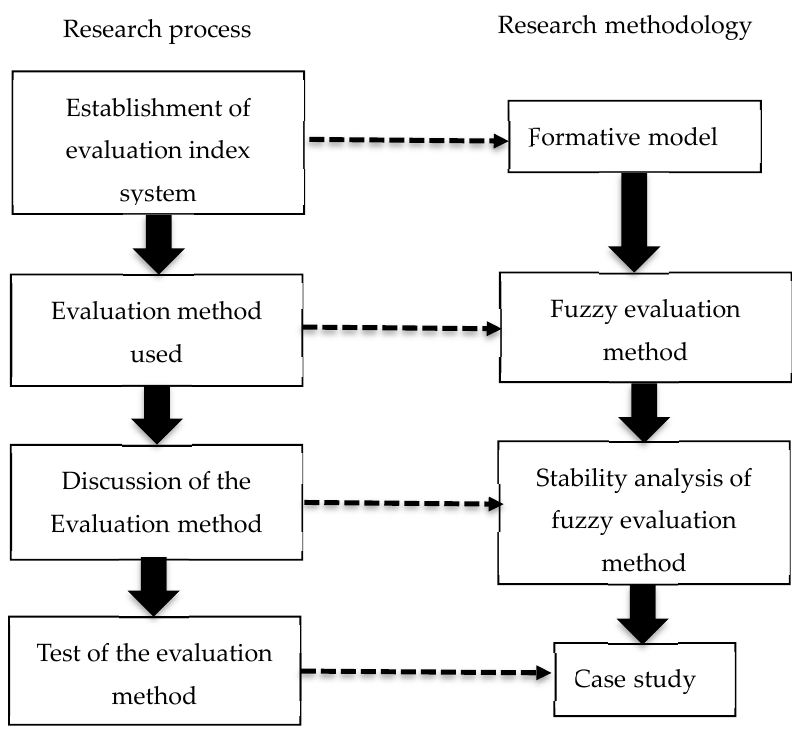
Figure 1. Research process and research methodologies.